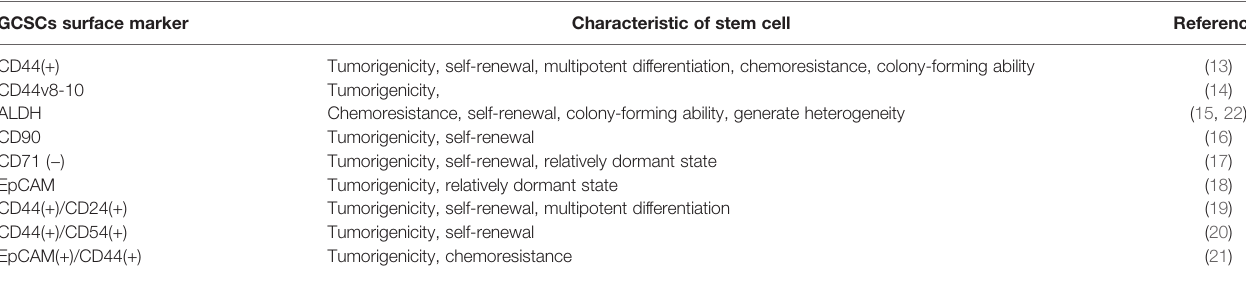
TABLE 1 | Cell surface markers of gastric cancer stem cells